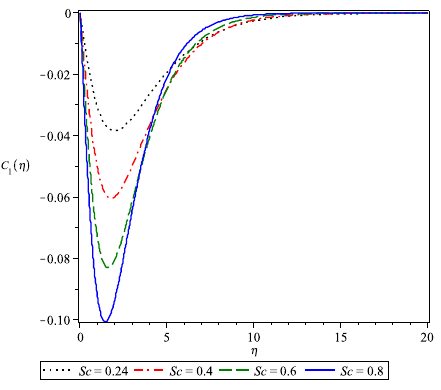
Figure 6. Dependency of concentration profile C 1 on the Schmidt number Sc when N = 0.8 and K = 0.2.